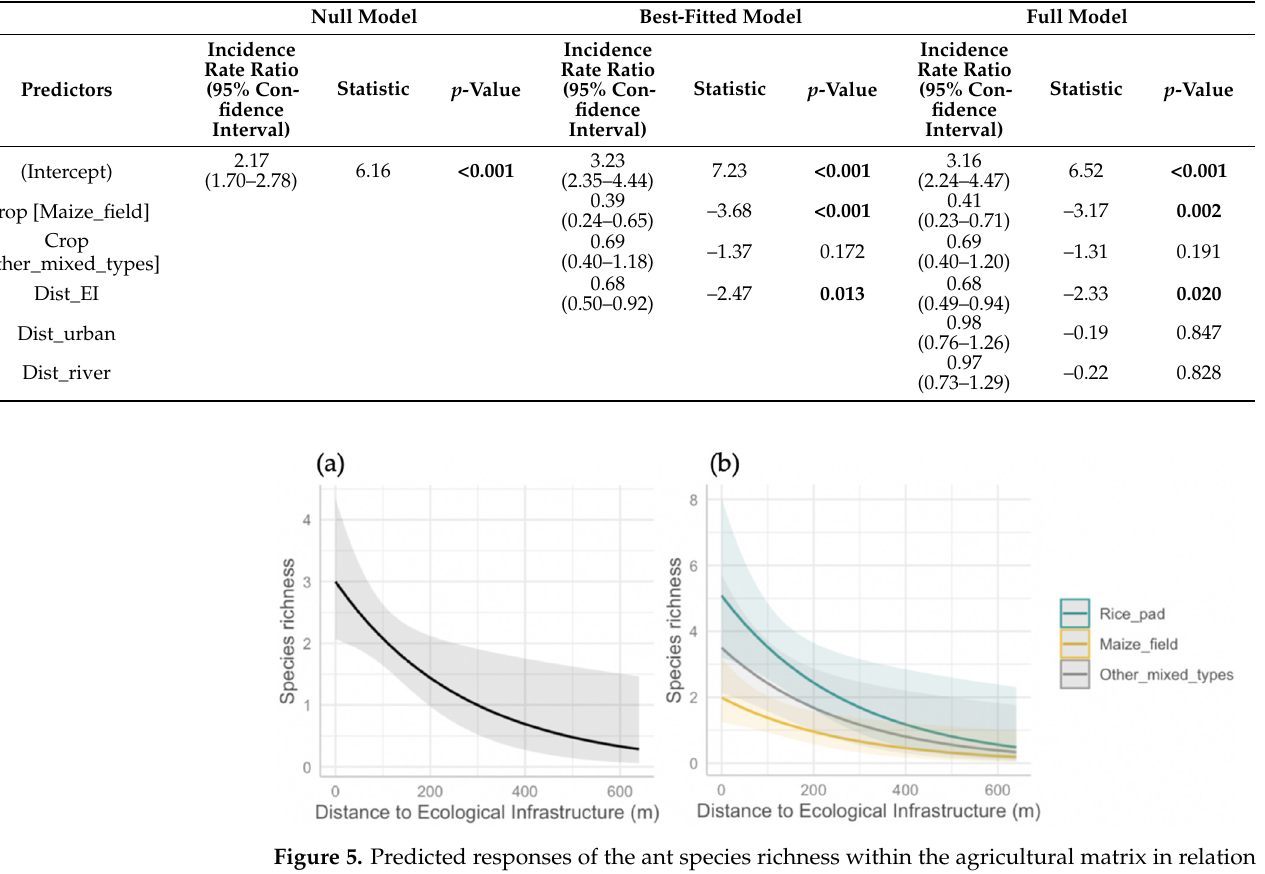
Figure 5. Predicted responses of the ant species richness within the agricultural matrix in relation to the distance to the nearest ecological infrastructure, ( a ) overall and ( b ) considering the crop type. Model predictions from GLMMs and associated 95% confidence intervals are represented by the solid lines and shaded areas, respectively.